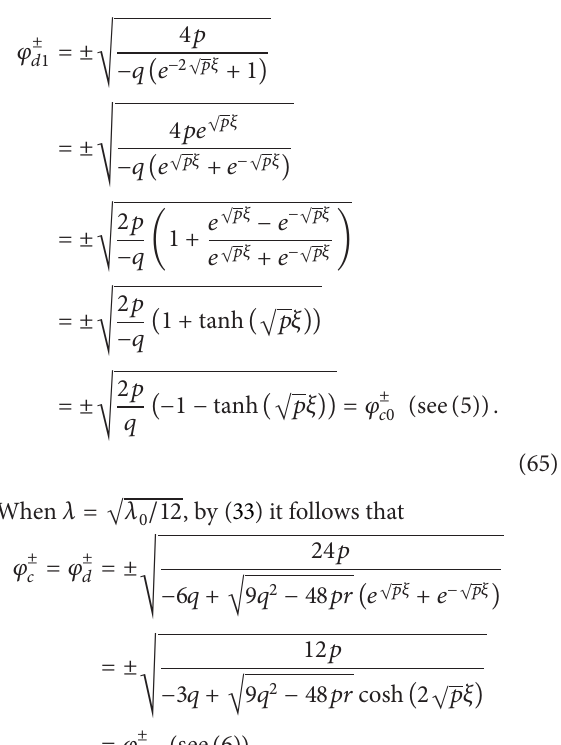
: 𝑝 = 3𝑞 2 /16𝑟 = 3, and 𝜇 = 4 and (a) 𝑝 = 3−0.5 , (b) 𝑝 = 3−10 −2 , 2